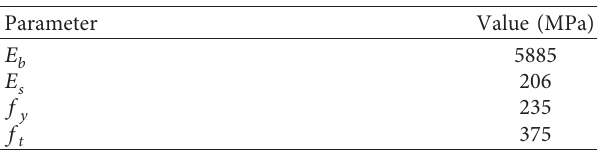
Table 2: Material properties.